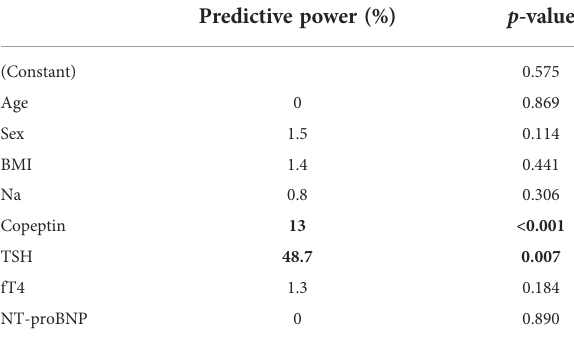
TABLE 4 A linear regression model with apelin as a dependent variable.